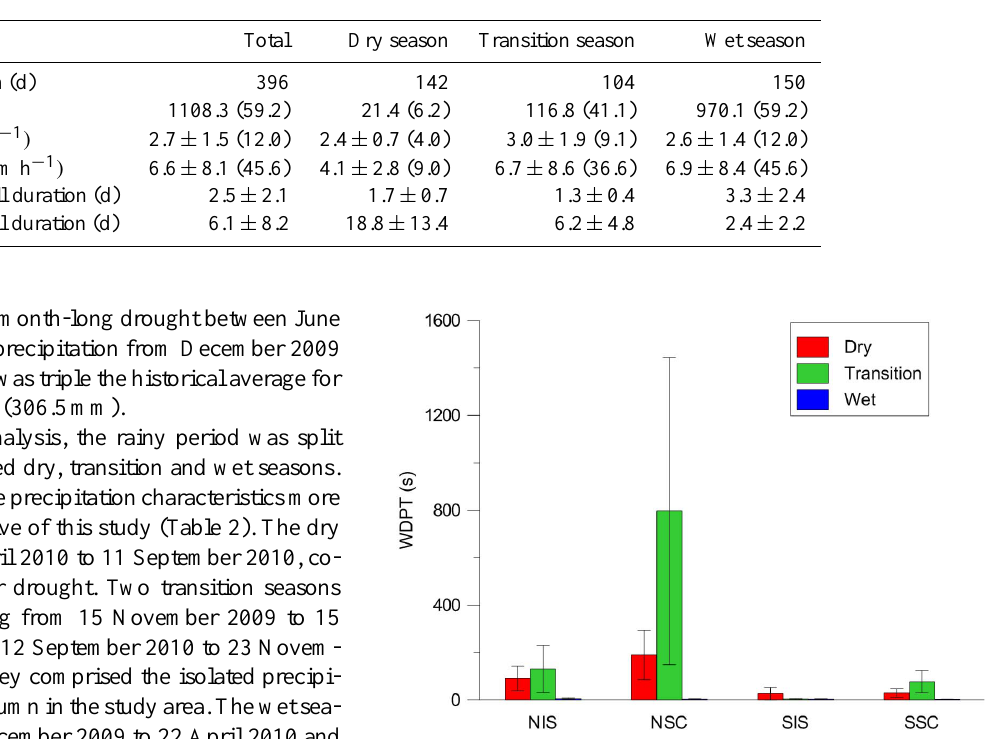
Table 2. Precipitation characteristics for the whole study period and for each season. P : precipitation; I : mean rainfall intensity; I max : maximum rainfall intensity. Daily maxima in brackets.